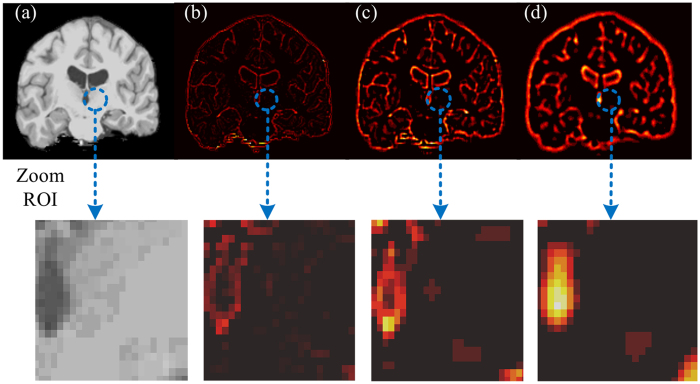
Example of multiscale texture.First row: Texturized T1-WI brain image (a) by LoG filter. The corresponding images selectively display, (b) fine, (c) medium and (d) coarse textures. Second row: zoom image illustrates the texture type within an ROI (blue color).